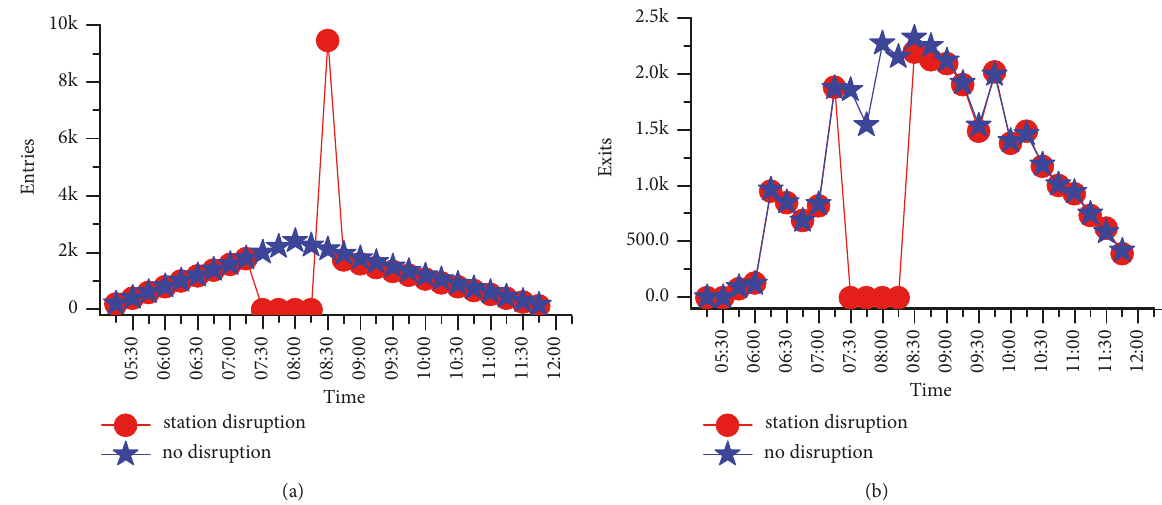
Figure 13: The number of entries and exits at the closed station Xizhimen. (a) shows entries of Xizhimen over time; (b) shows the exits of Xizhimen over time.